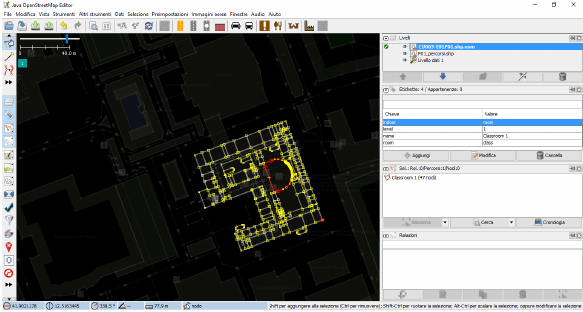
Figure 5. Visualization of the first floor of the faculty of Letters and Philosophy within the JOSM